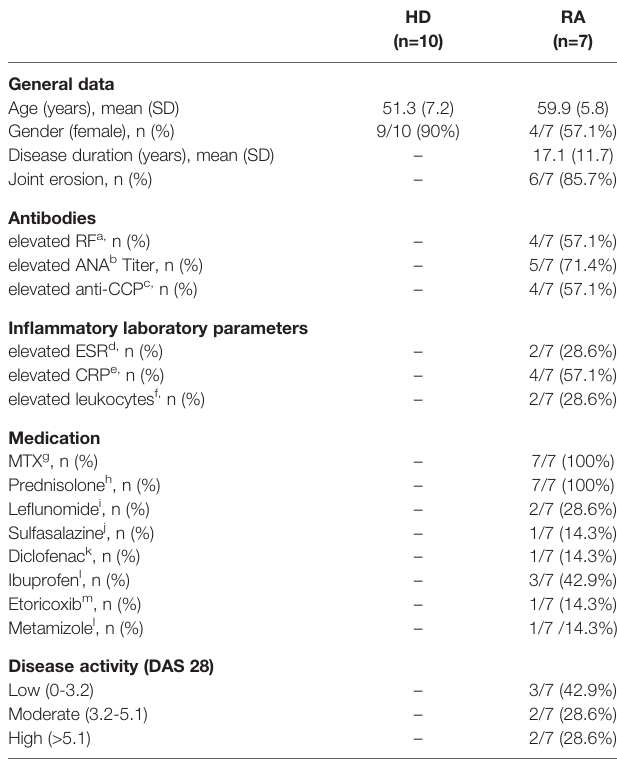
TABLE 1 | Clinical and laboratory characteristics of HD and